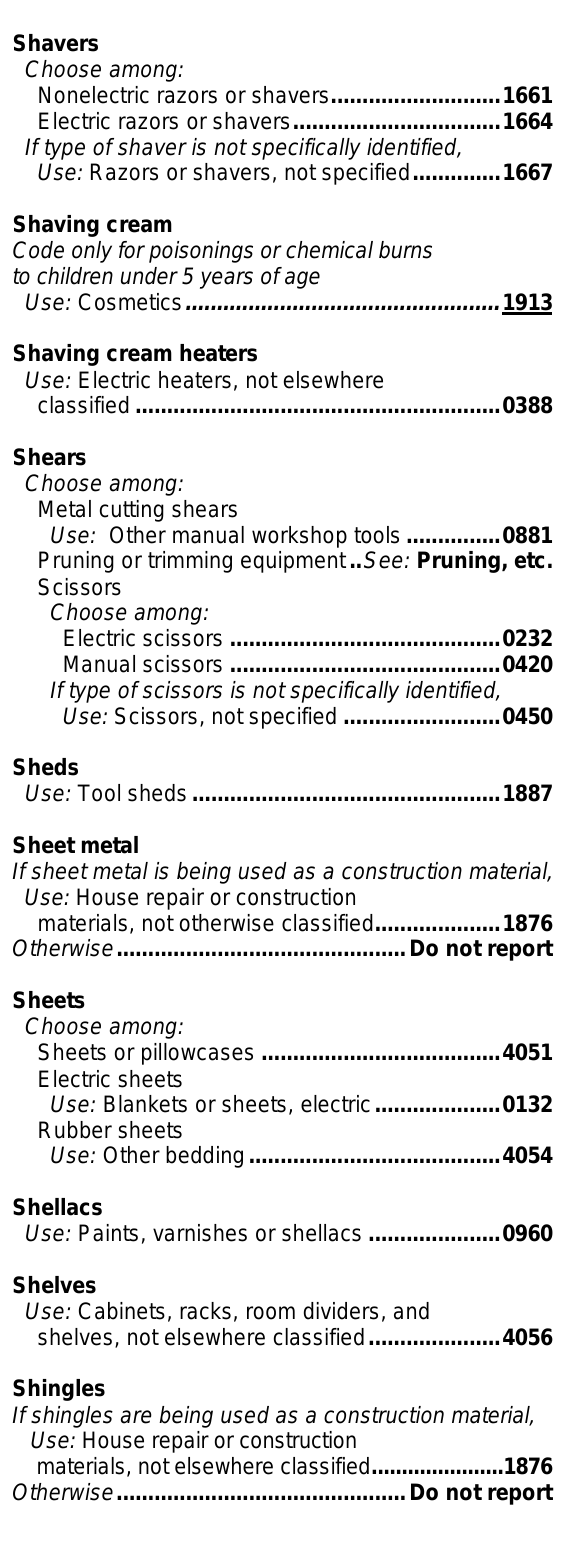
Serving bowls Use: Tableware and accessories Sewing basket articles (excl. scissors, pins, Sewing kits Use: Sewing basket articles (excl. scissors, pins,